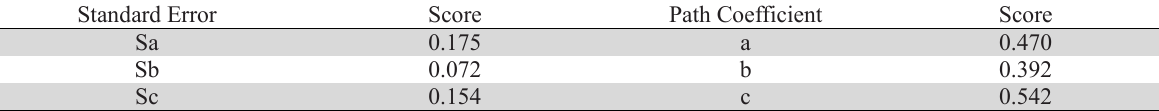
Standard Error Value and Direct Effect Path